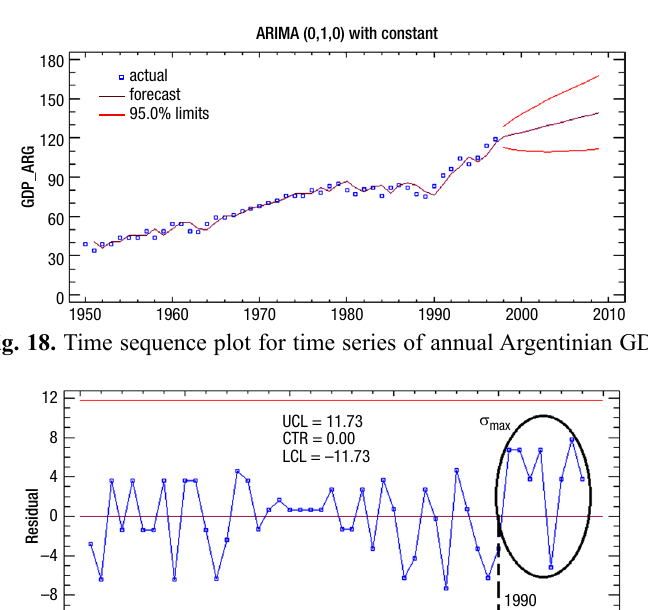
Fig. 17. Forecast plot for time series of annual Argentinian GDP